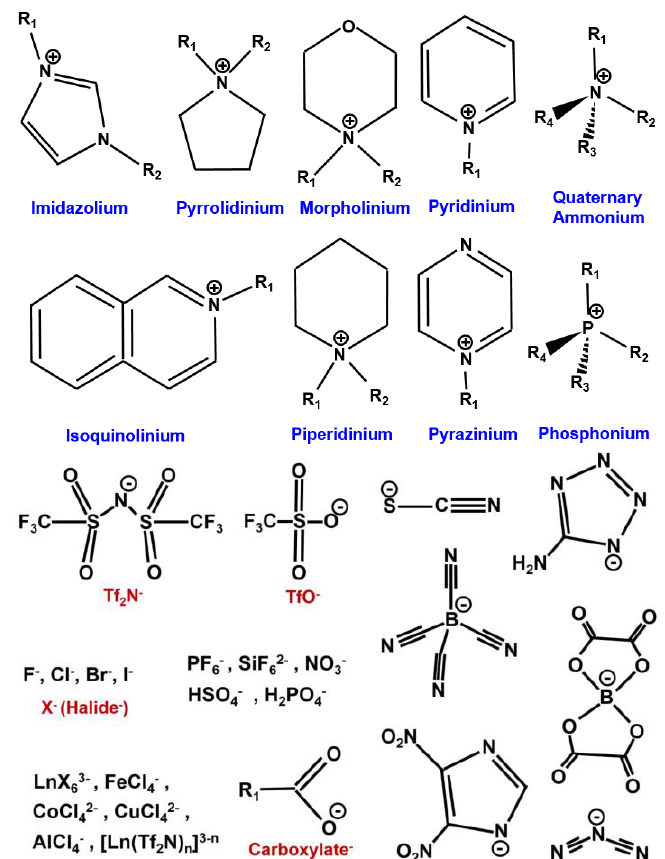
Figure 1. Common cations and anions of ionic liquids. Reprinted from Coordination Chemistry Reviews , 363, D. Prodius, A.-V. Mudring, Rare earth metal-containing ionic liquids, 1 – 16, Copyright (2018) [10], with permission from Elsevier.